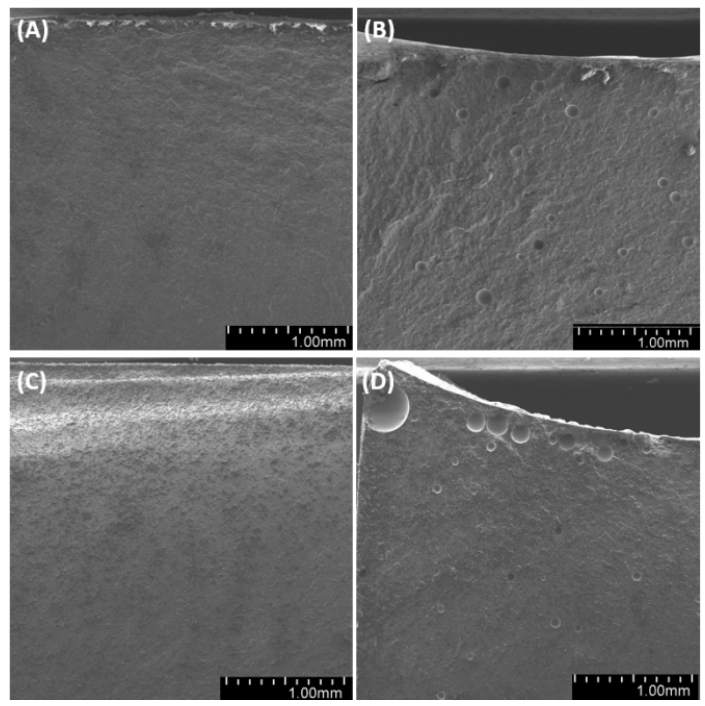
Figure 23. SEM images of sample fractures: 48% vol. of diatoms: ( A )—base deg, ( B )—base no deg, ( C )—fractionated deg, ( D )—fractionated no deg.